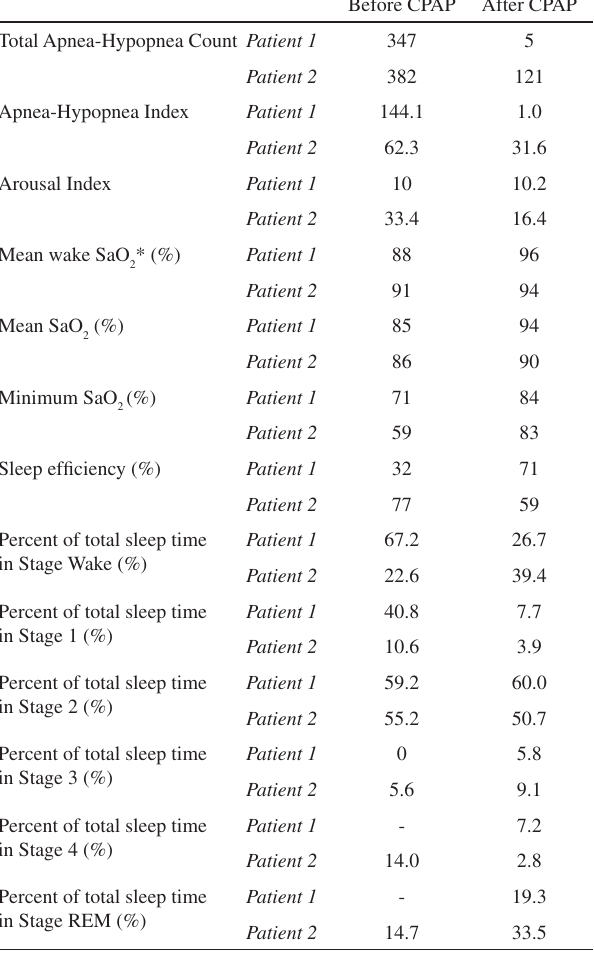
Table 2 - Polysomnography data of patients before and after continuous positive airway pressure